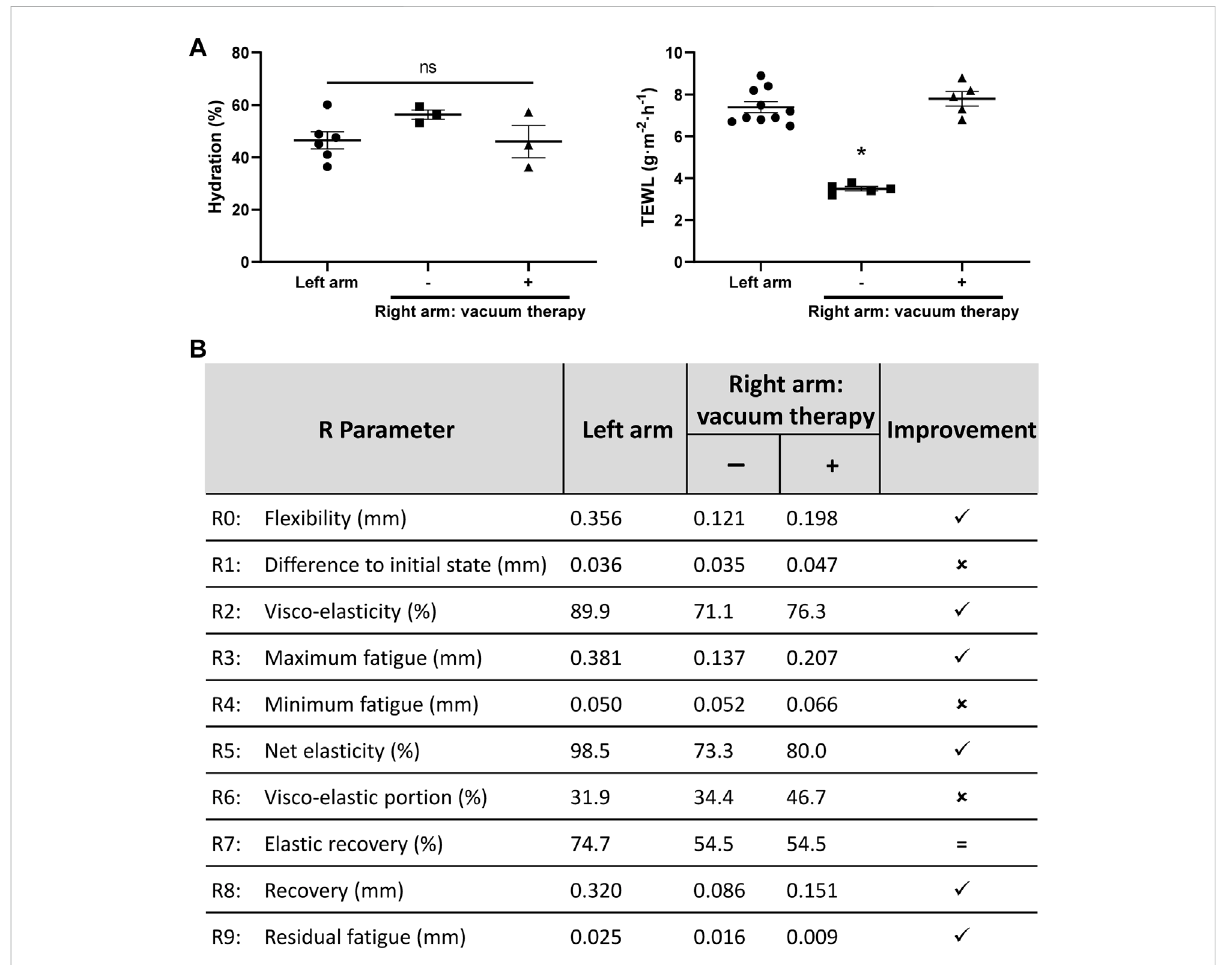
FIGURE 3 Mechanicalandbiophysicalcharacterizationoftheskinintheregeneratedarea. (A) Hydrationparametersoftheskin.Thehydrationpercentage, measured with a corneometer, is shown on the left, comparing both healthy skin from left arm with regenerated skin from right arm. The trans epidermal water loss (TEWL) is reported on the right, comparing both healthy skin from control arm with regenerated skin from right arm. Four measurements were made at either arm in each timepoint. The effect of the vacuum massage treatment on right arm can be seen for both parametersmeasured.Leftarmvaluesaretheaverageofmeasurementsattwodifferenttimepoints.ns,notsigni fi cantdifferences;* p < 0.0001,one- way ANOVA. (B) Mechanical evaluation of the skin. Consecutive deformation cycles were performed on the skin using a cutometer, to assess for elastic properties of both healthy and regenerated skin. The measurements were repeated after the vacuum therapy. R parameters were calculated, and a qualitative improvement index is shown, stating if parameters improved on the right arm after the vacuum therapy sessions, relative to values obtained for the left